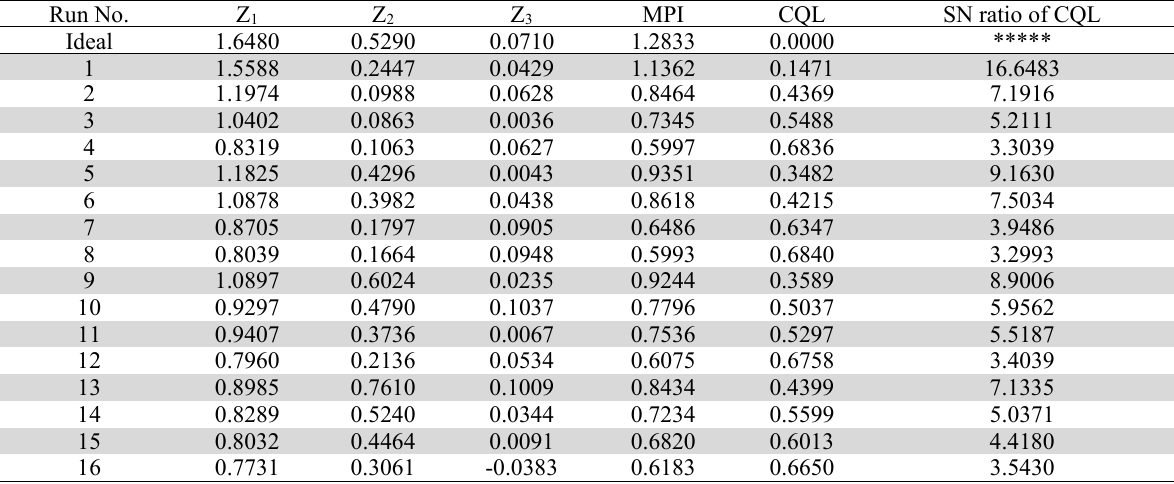
Individual principal components, Multi-response performance index and Combined quality loss Run No.